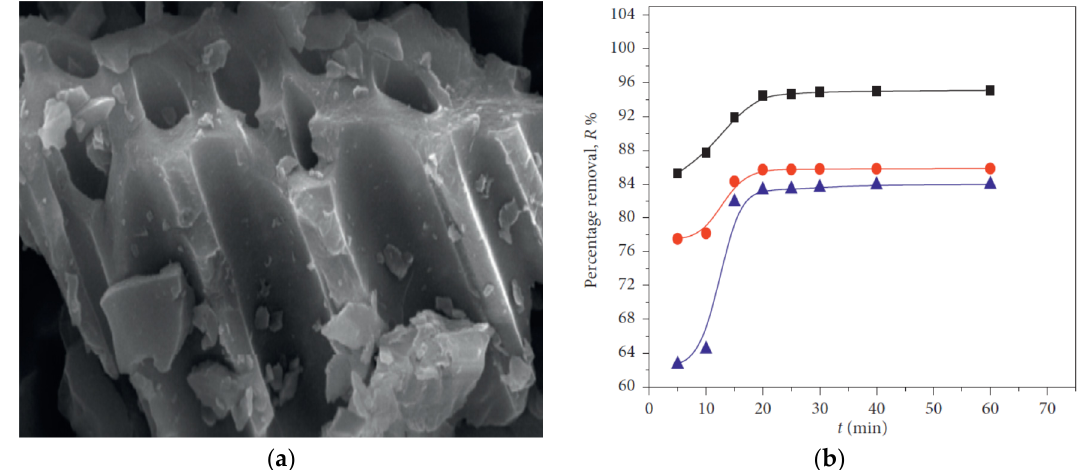
Figure 9. SEM image and adsorption behavior of activated carbon derived from guava tree wood: ( a ) SEM image, ( b ) adsorption of brilliant green dye solution with different concentrations (- ■ - 25 ppm; - ● - 50 ppm; - ▲ - 75 ppm). Reprinted from [19], ©2020 The Authors.